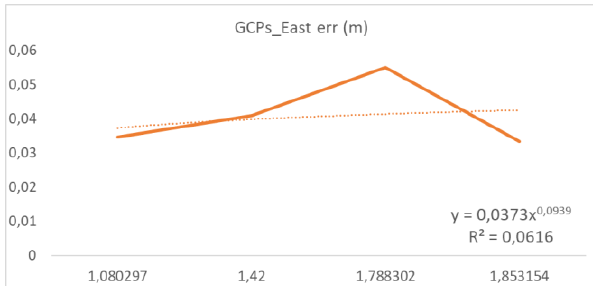
Figure 18. Predictive function extracted through a power interpolation between depend (synthetic index) and independent variables (eastern error component). R 2 : coefficient of